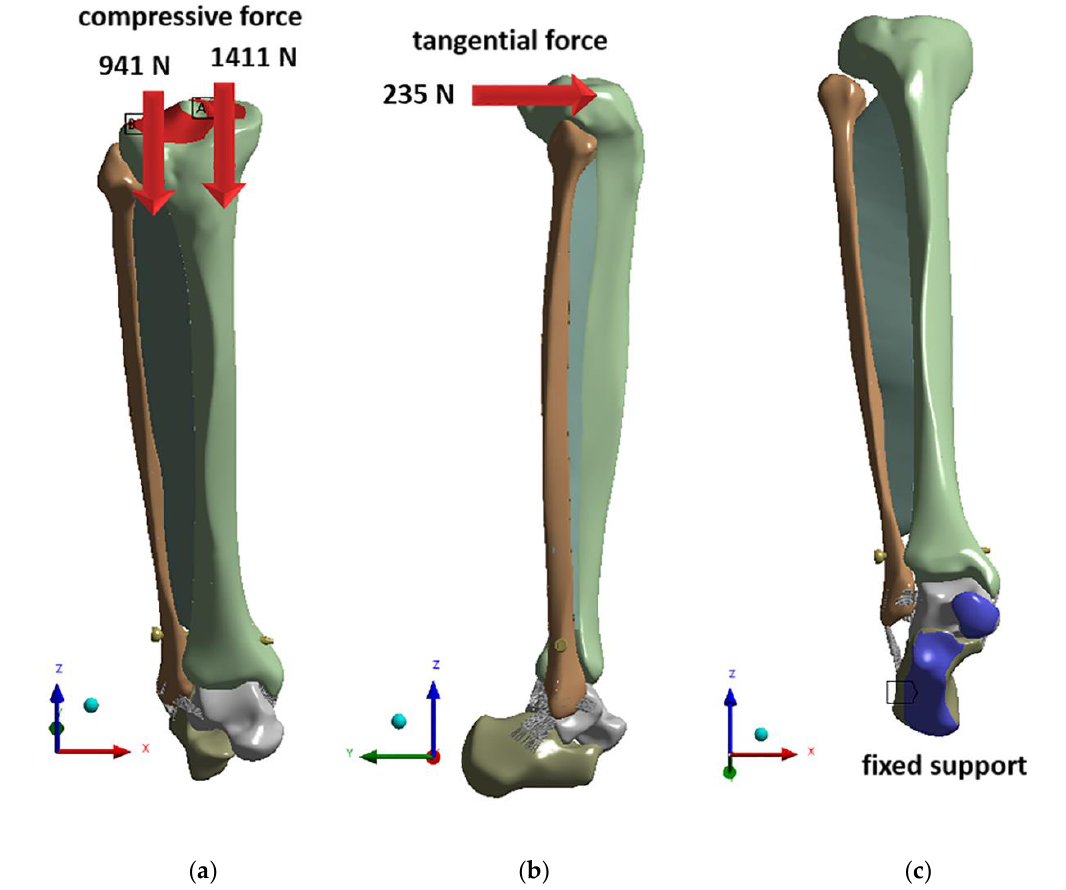
Figure 3. Loading conditions applied to the finite element (FE) model: ( a ) compressive force, ( b ) tangential force, and ( c ) fixed support.